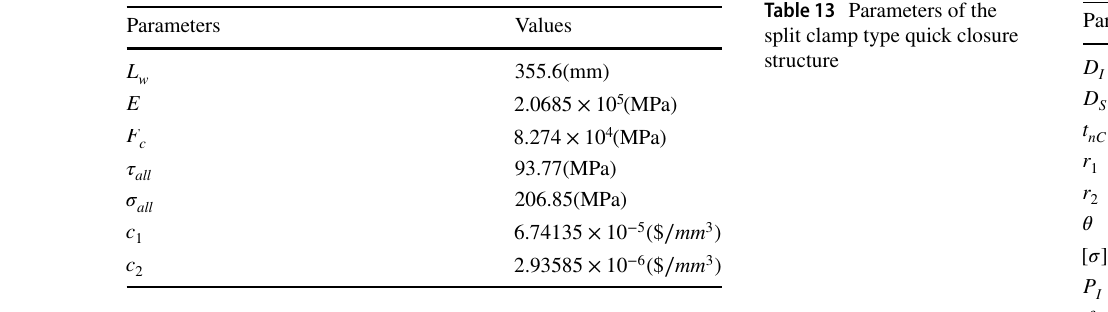
Fig. 12 The best Pareto optimal fronts obtained by WSM-DMOEOA, GFWSM-DMOEOA and DMOEOA on MORBDO test example 3 under different target reliability levels Table 10 Parameters of the welded beam design problem